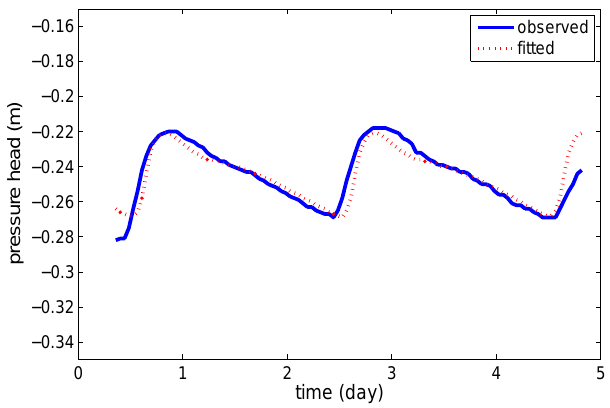
Fig. 5. Observed and fitted pressure heads at 0.5 m depth for the irrigation experiment.